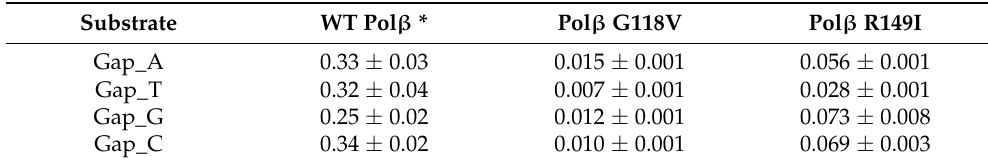
Table 3. Observed rate constants k obs (s − 1 ) of gap-filling incorporation of various dNTPs into the DNA